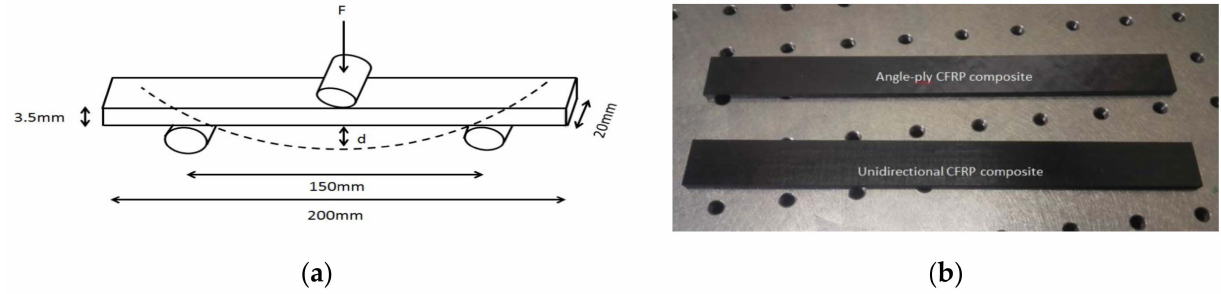
Figure 6. ( a ) Three-point bending specimen dimensions and loading condition; ( b ) UD and Angle-ply specimens.